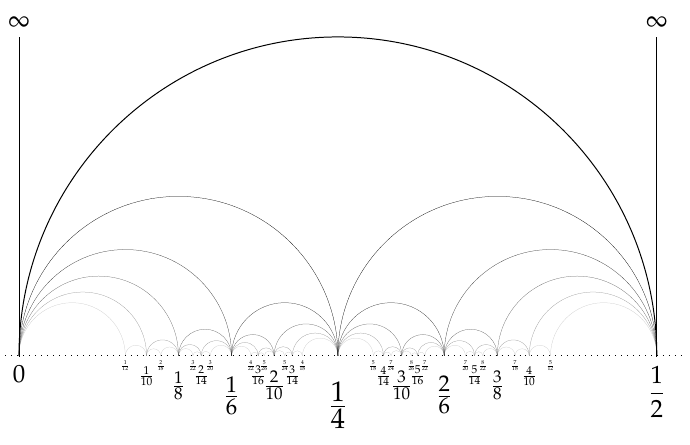
Figure 1. Part of the normalizer map M 2